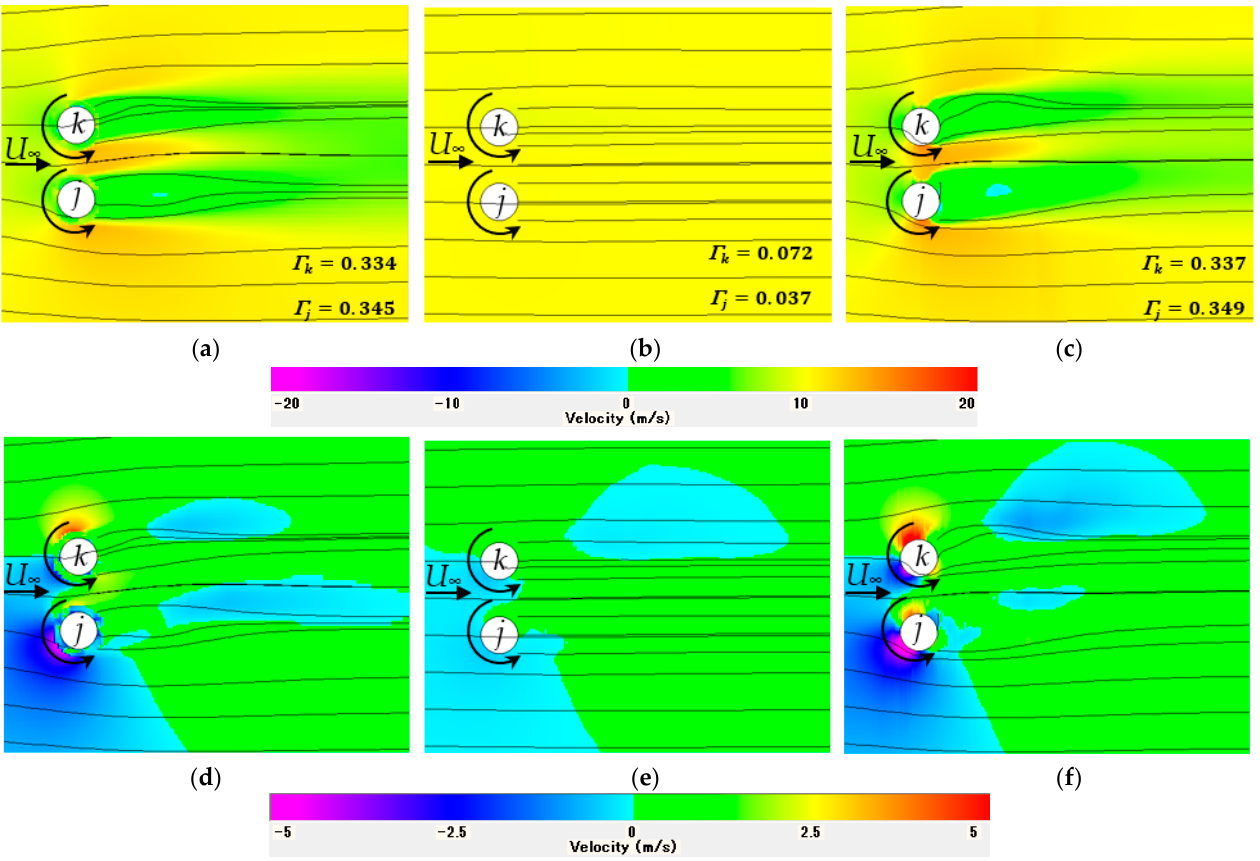
Figure 6. The distribution of the x -component velocity around two rotors in the CO-like layout: ( a ) CFD; ( b ) model with a wide searching range; ( c ) model with a narrow searching range. The distribution of the y -component velocity around two rotors in the CO-like layout: ( d ) CFD; ( e ) model with a wide searching range; ( f ) model with a narrow searching